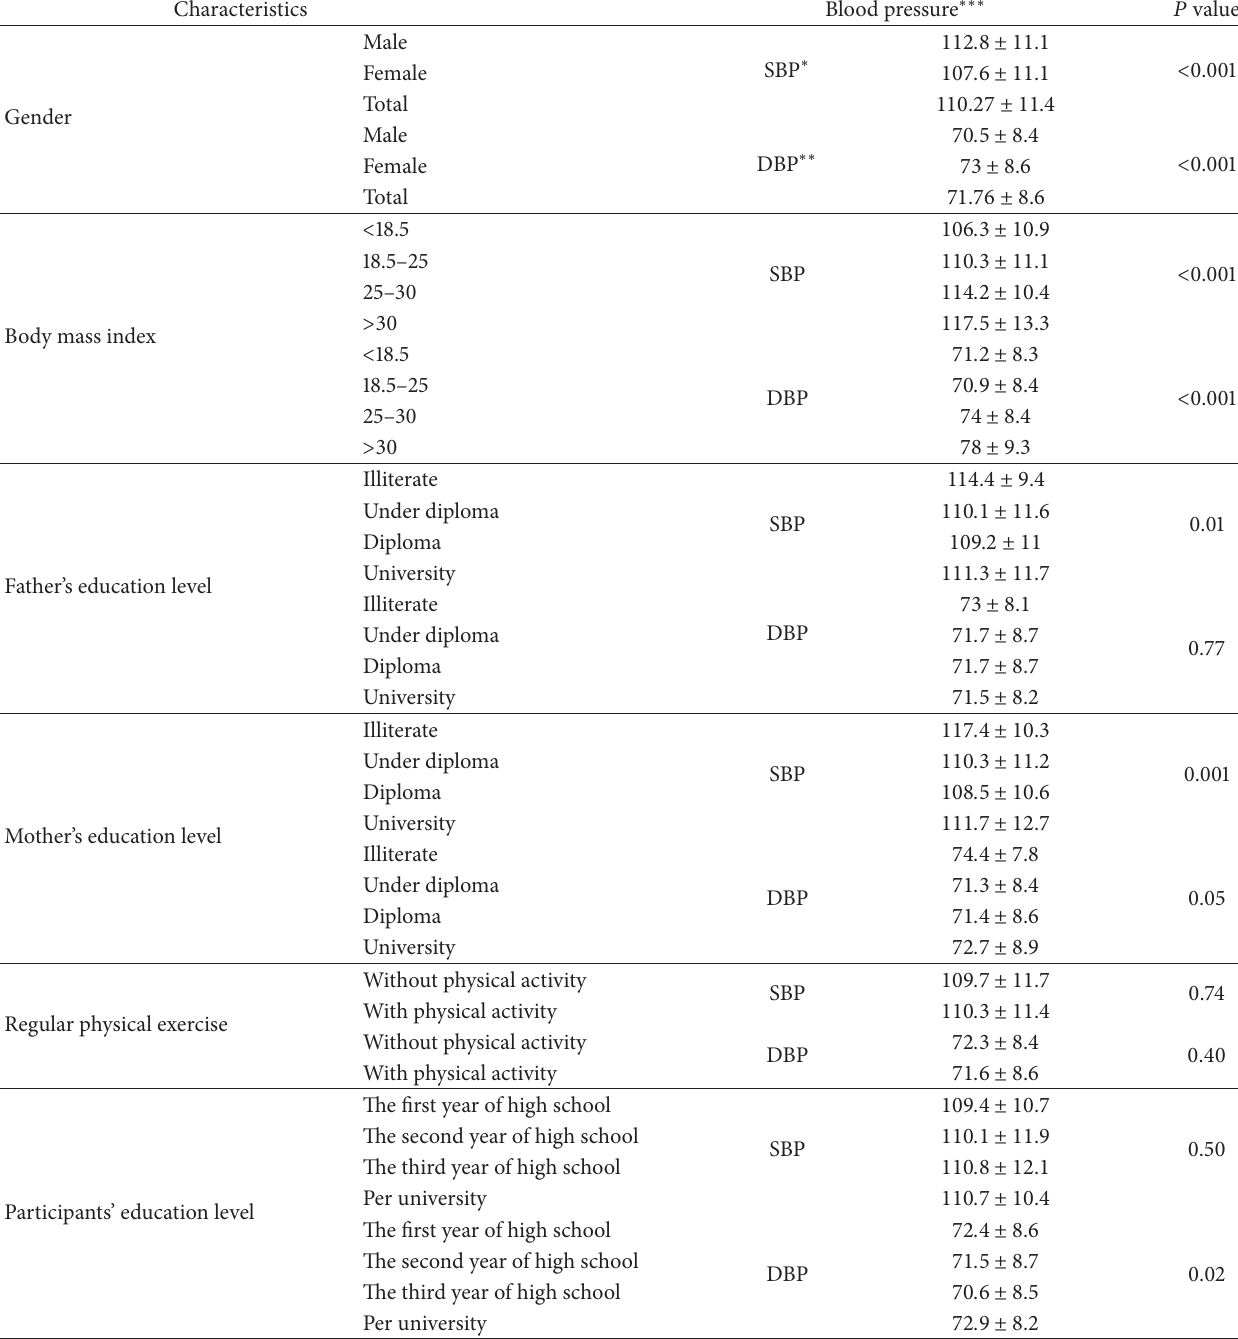
Table 1: Average of systolic and diastolic blood pressure among Jahrom high school students in terms of demographic and anthropometric